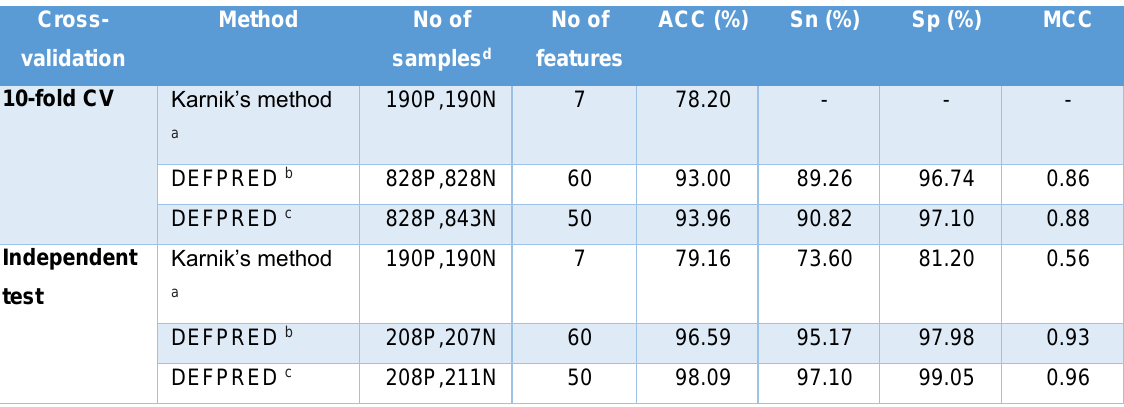
Table 3: Performance comparison of Karnik’s method and DEFPRED for the prediction of defensins Cross-